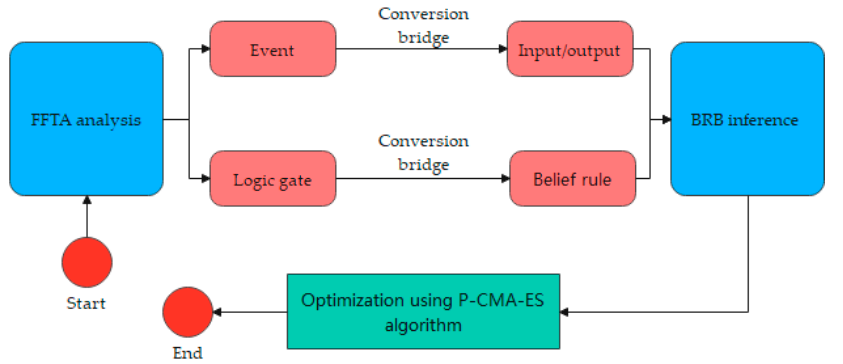
Figure 6. FFBRB flywheel system fault diagnosis model diagram.